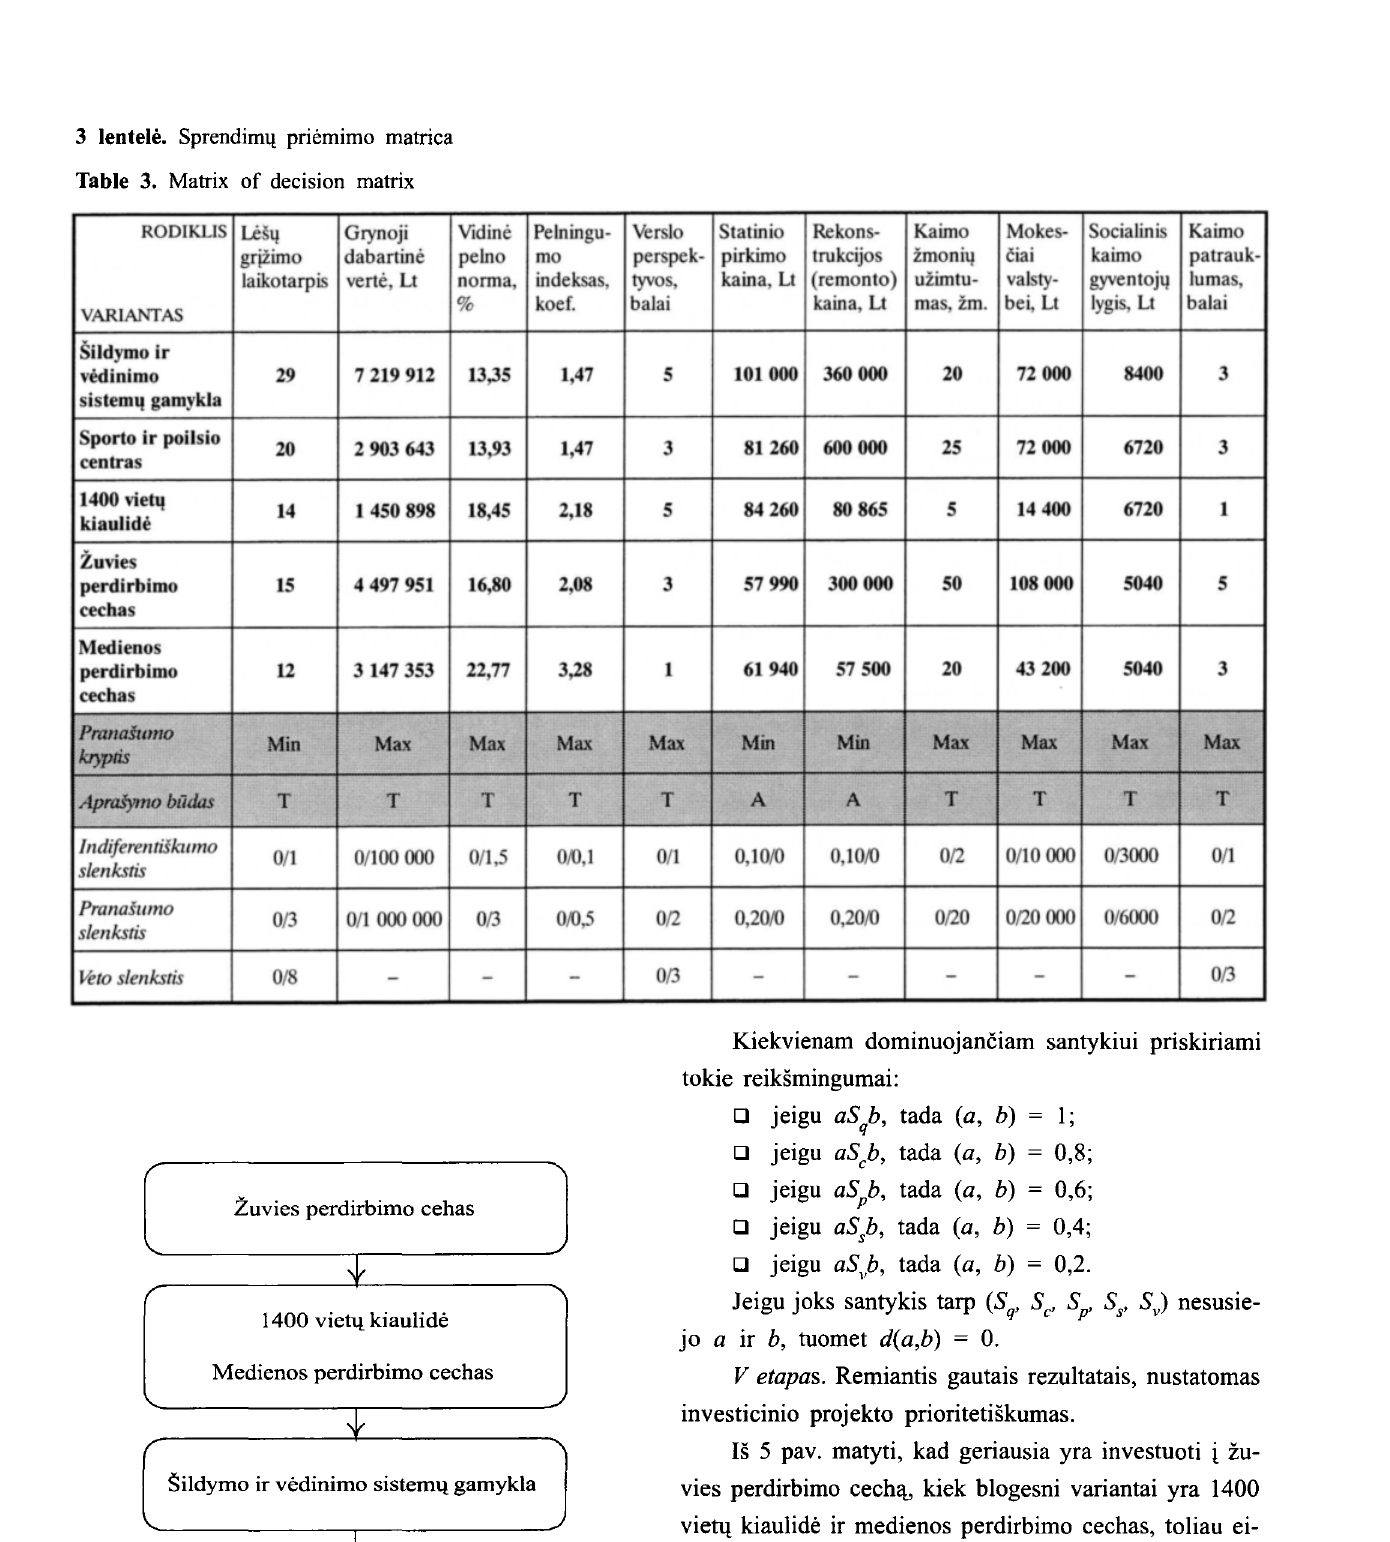
Fig 5. Ranks in final